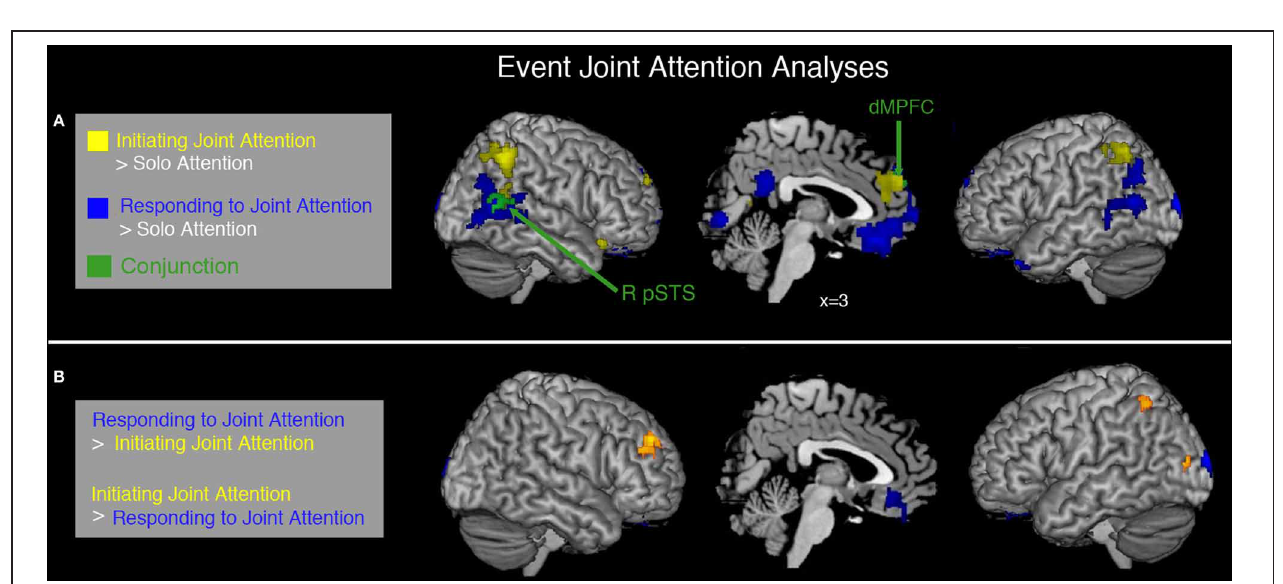
response to both RJA and IJA (greater than SA) are shown in green (and labeled). In (B) distinct regions between responding (RJA, orange/yellow) and initiating (IJA, blue) joint attention are shown with each masked by the contrast of joint attention (RJA or IJA) as compared to solo attention. The masks were created with a more liberal threshold ( p < 0 . 001, cluster-correct p < 0 . 05).